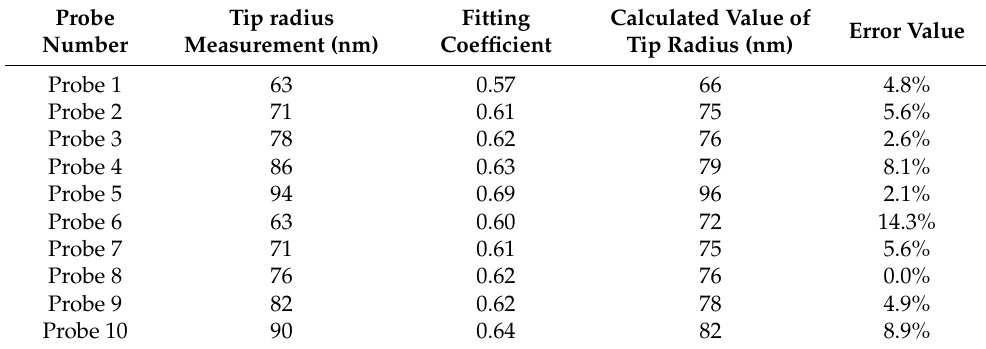
Table 2. Calculation results and error analysis of wear tip radius of Probes 1~10.